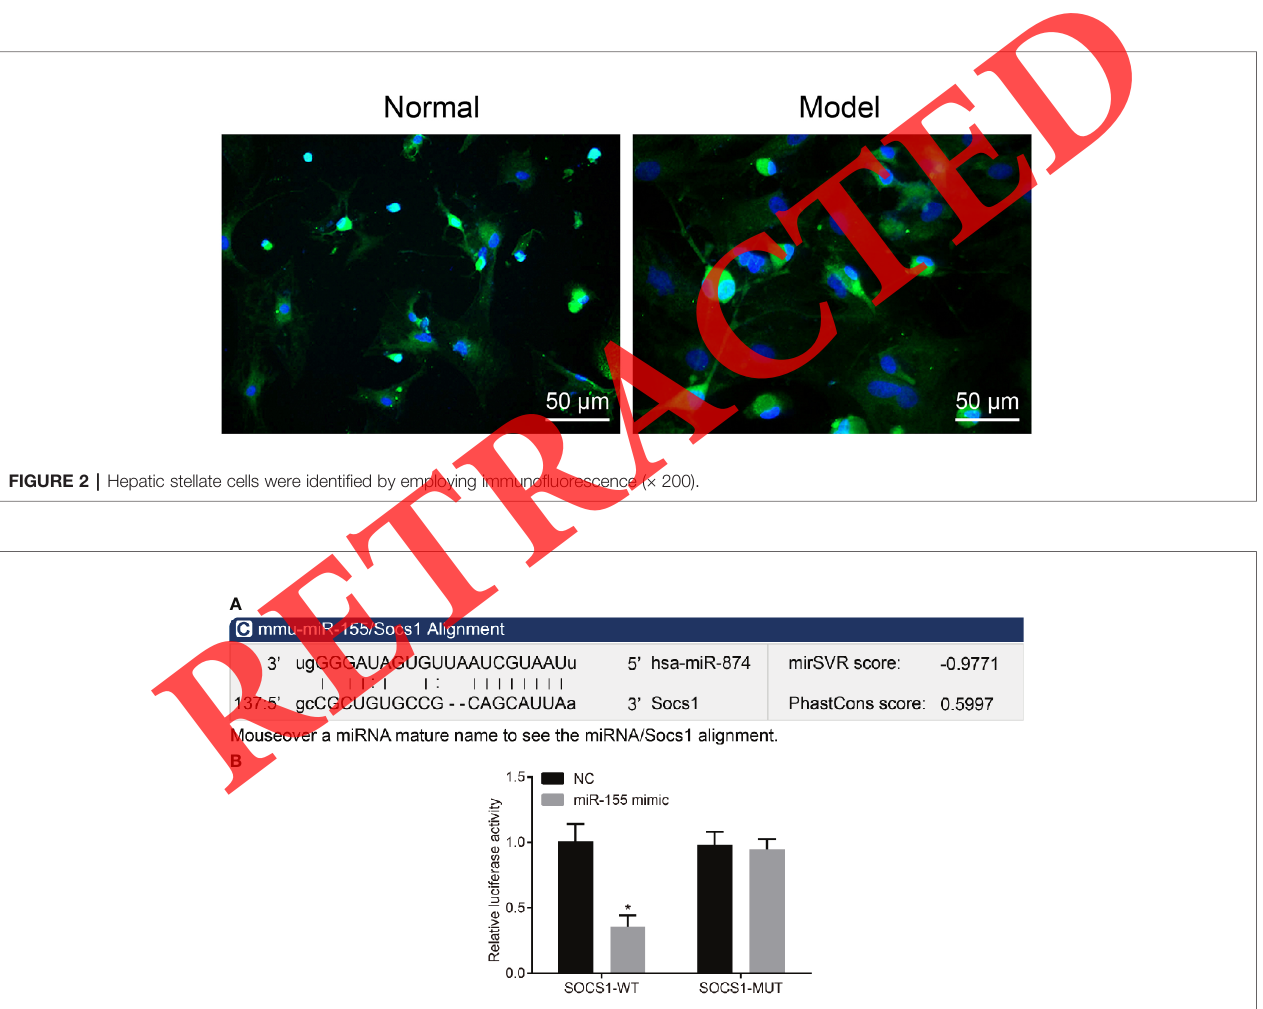
FIGURE 3 | miR-155 targets SOCS1. (A) The predicted binding site of miR-155 on 3 ’ UTR of SOCS1. (B) The activity of luciferase of SOCS1 wild-type 3 ’ UTR and mutant 3 ’ UTR. * p < 0.05 vs . hepatic stellate cells transfected with miR-155 NC. The measurement data are expressed as mean ± standard deviation and compared by unpaired t -test. The cell experiment was repeated three times. SOCS1, suppressor of cytokine signaling 1; UTR, untranslated region; NC, negative